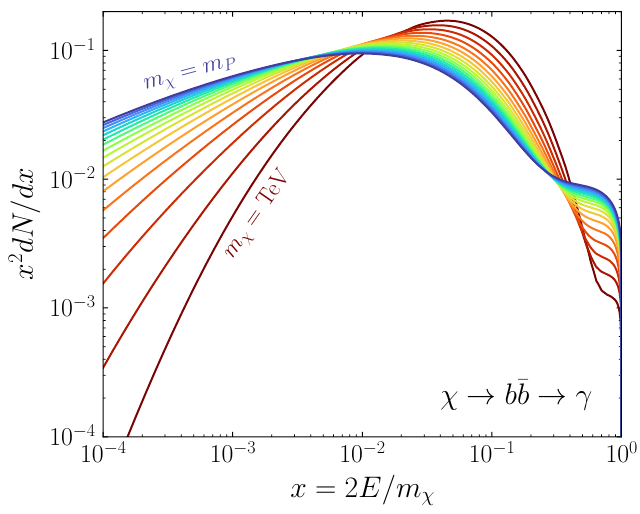
¯ b , shown across the entire mass range